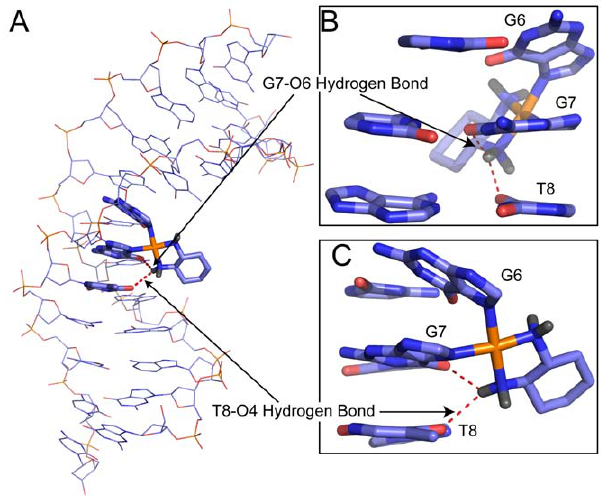
Figure 7. Hydrogen bond formation between the platinum amines and adjacent bases in OX-TGGT DNA adducts. Repre- sentative structure of OX-DNA in the TGGT sequence context that forms both the G7-O6 hydrogen bond and the T8-O4 hydrogen bond is shown using line representation ( A ) in PyMOL (www.pymol.org). The dach ligand, G6, G7 and A8 bases are shown using stick representation. The dach ligand, G6, G7 and A8 base-pairs of the same structure are shown in greater detail with the minor groove facing the reader ( B ) and along the side ( C ).